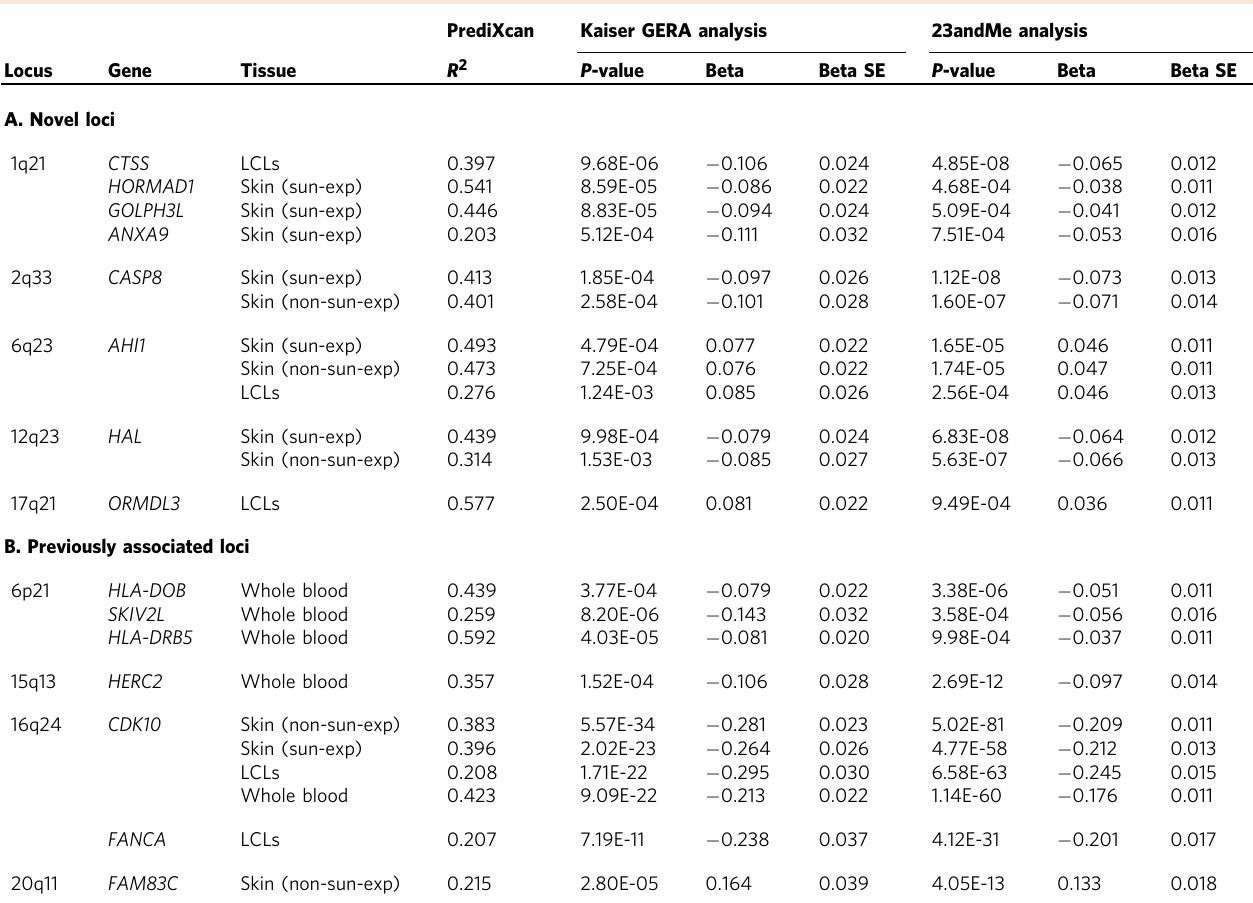
Table 1 Genes associated with cSCC in the discovery-validation